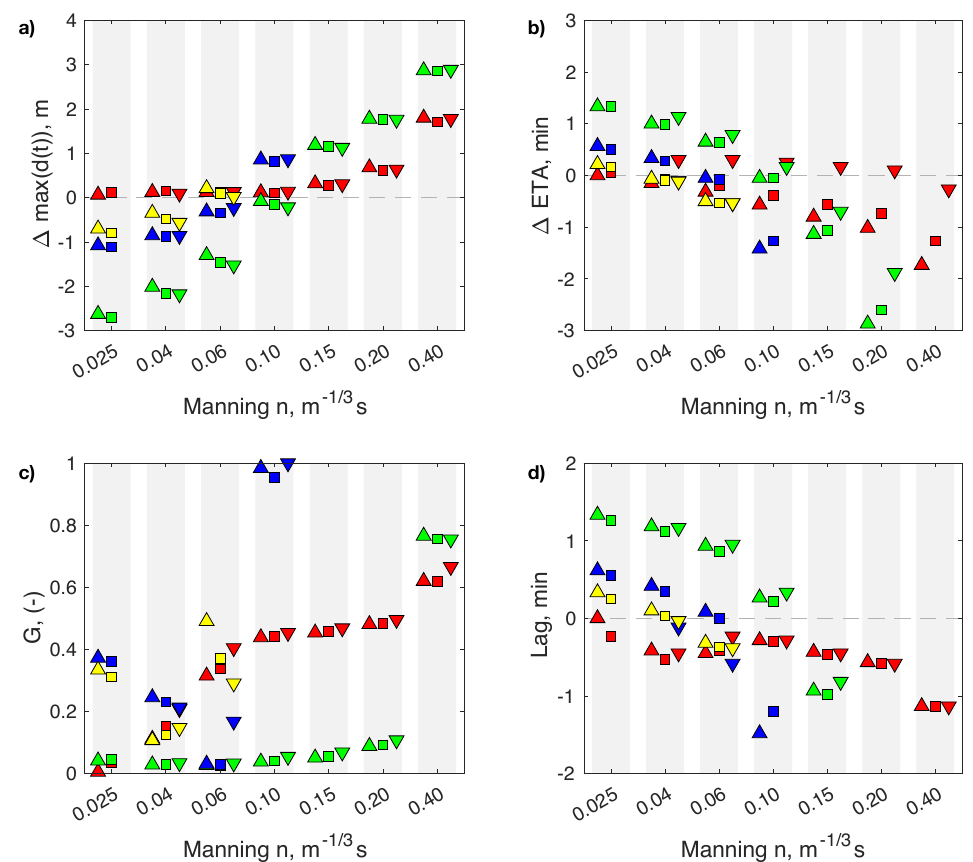
Figure 6. Summary statistics for all inland gauges, as function of Manning n values. ( a ) Maximum difference in flow depth; ( b ) Difference in arrival time; ( c ) G parameter; and ( d ) Estimated time lag. Red, green, blue, and yellow markers denote inland gauges 1, 3, 5, and 7, respectively. Symbols also denote the resolution: (cid:52) R 1 , (cid:3) R 2 , (cid:53) R 3